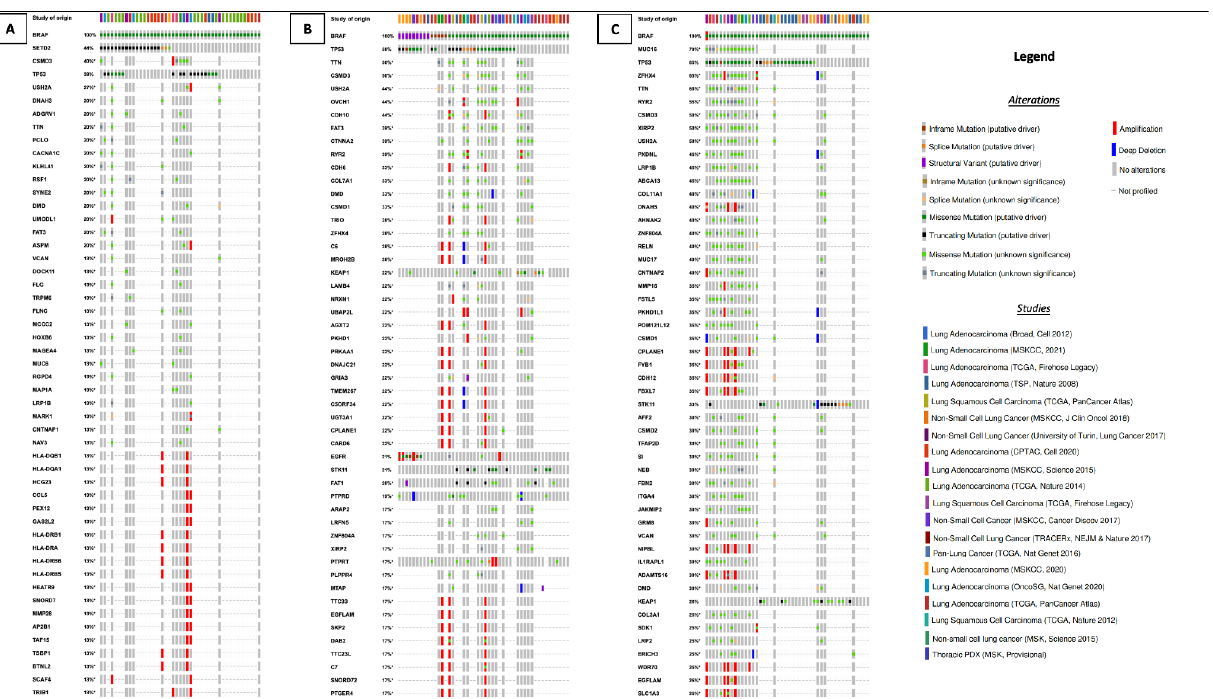
Figure 4. Top 50 most frequently altered genes in patients harboring BRAF alterations of class 1 ( A ), 2 ( B ), and 3 ( C ), the type of alteration, and the study of origin of each patient. Concurrent gene alterations showed significant heterogeneity among the three BRAF functional classes (Figure 5C – E). In fact, 47 of the most commonly co-altered genes (top 50) and key genes in each class showed statistically significant different co-alteration fre- quency between the three functional classes of BRAF alterations, including SETD2 ( p < 0.0001), STK11 ( p = 0.0002), POM121L12 ( p = 0.001), MUC16 ( p = 0.002), OVCH1 ( p = 0.003), ZFHX4 ( p = 0.004), ITGA4 ( p = 0.004), KEAP1 ( p = 0.005), TERT ( p = 0.002), RAS ( p = 0.006), TP53 ( p = 0.024), FGFR1/2/3/4 ( p = 0.042), ALK ( p = 0.047) and DNA damage response and repair (DDR) genes ( p = 0.049) (Supplementary Table S2). A statistically significant mutual exclusivity in patients with BRAF alteration of any class was documented between STK11 and either TP53 ( p = 0.011; q = 0.044) or TTN ( p = 0.004; q = 0.023) co-alterations, and be-